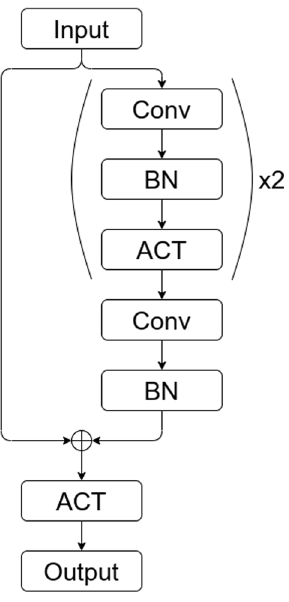
Fig. 4 Residual block in ResNet50. (Conv: convolutional layer, BN: batch normalization layer, and ACT: ACTivation